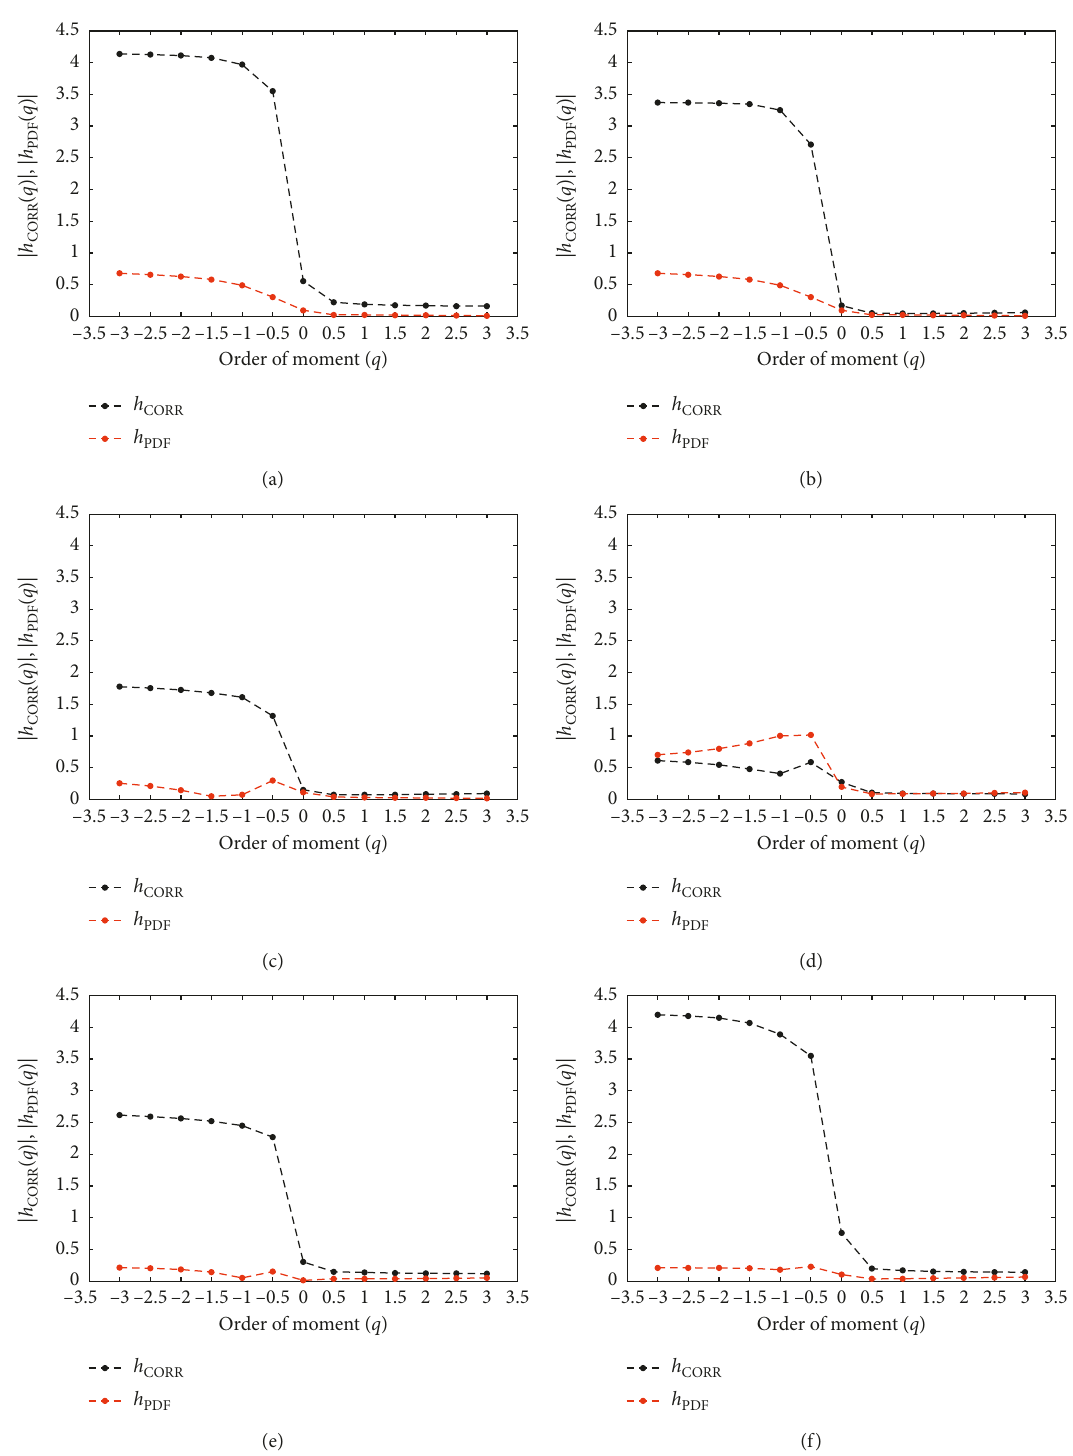
Figure 5: Absolute difference of Hurst exponents | h function), q � − 3:0.5 :3 at each synoptic station: (a) Cotonou station, (b) Bohicon station, (c) Sav`e station, (d) Parakou station, (e) Natitingou station, and (f) Kandi